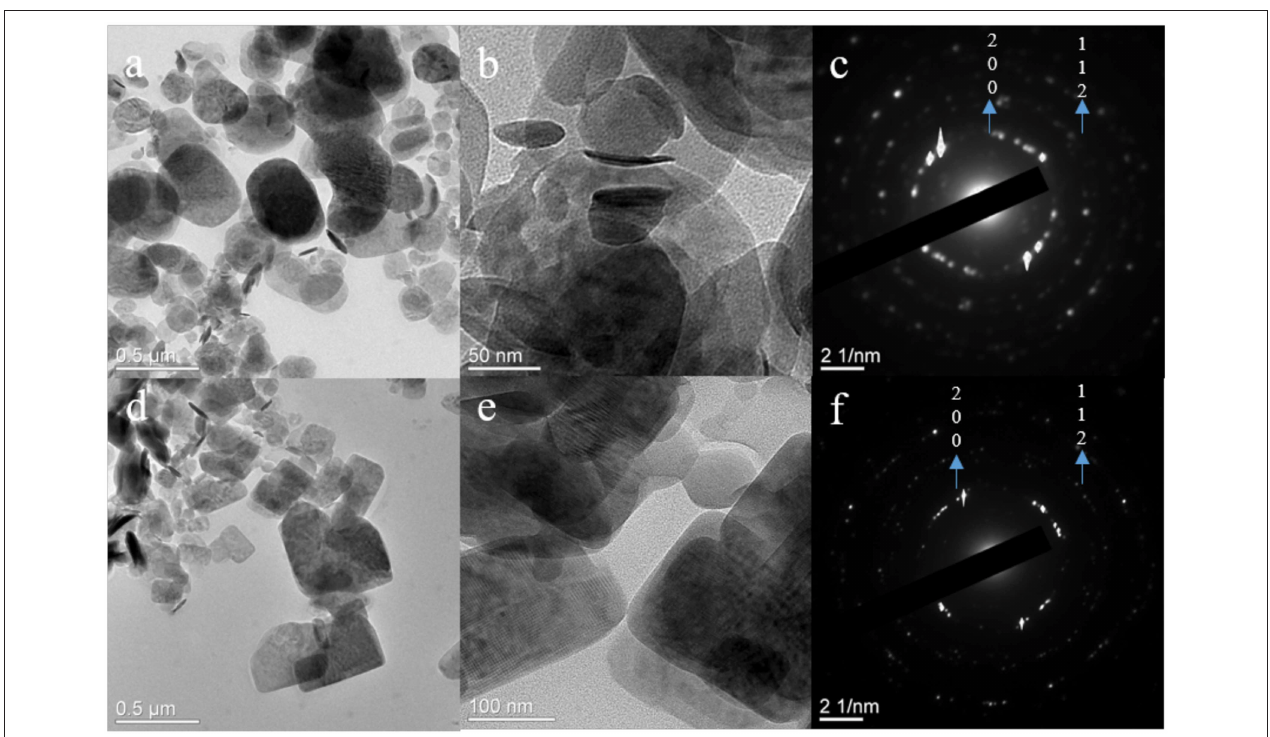
FIGURE 7 | TEM images and corresponding SAED pattern for calcined particles from (a–c) sucrose-based solutions and (d–f) DMF-based